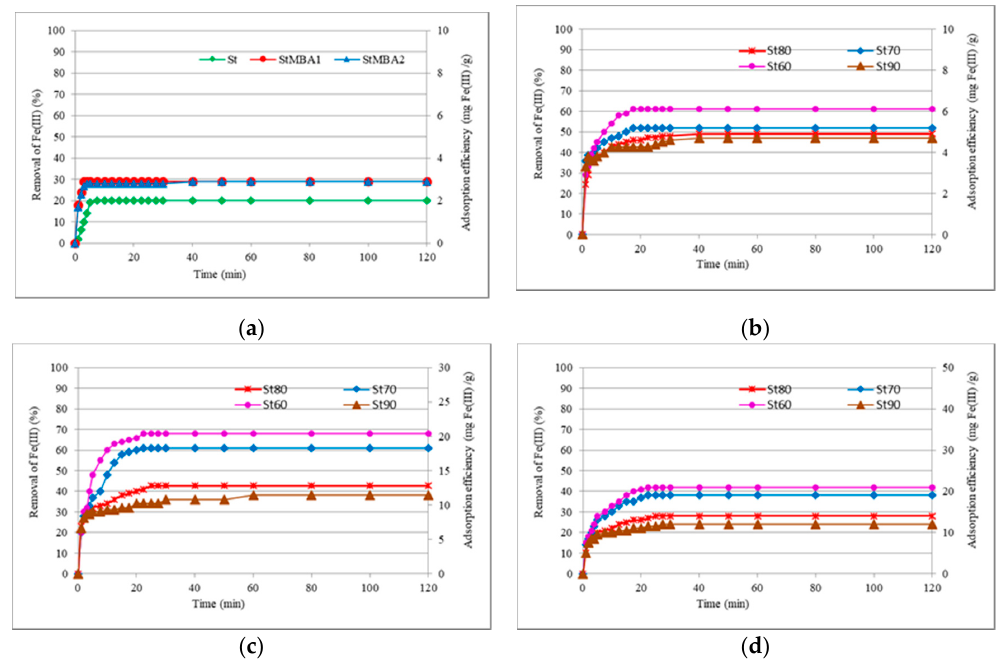
Figure 8. The removal of Fe(III) (%) and adsorption efficiency (mg Fe(III)/g) in time of initial concentration 10 Fe(III) mg/L ( a ) for St, StMBA1 and StMBA2; ( b ) for starch SAPs with different amount of natural polymer; ( c ) for starch SAPs of initial concentration 30 Fe(III) mg/L ; ( d ) for starch SAPs of initial concentration 50 Fe(III) mg/L.